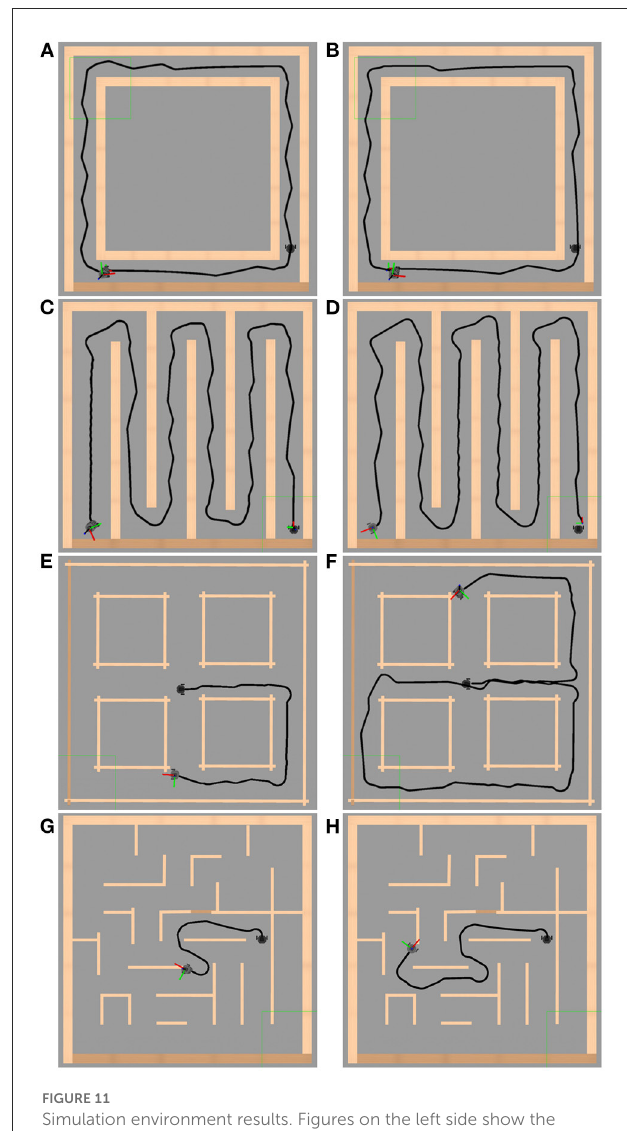
FIGURE11 Simulation environment results. Figures on the left side show the Gazebo simulation environment without the meta-control circuit. The right side images show the trajectory made by the robot in the exploration behavior with the meta-control circuit. (A, B) Loop. (C, D) Zigzag. (E, F) Cross. (G, H) Traditional maze. In (B, D, F, H) , one can observe how we obtain a better performance using the meta-control network and allowing to achieve a greater trajectory in (F, H)